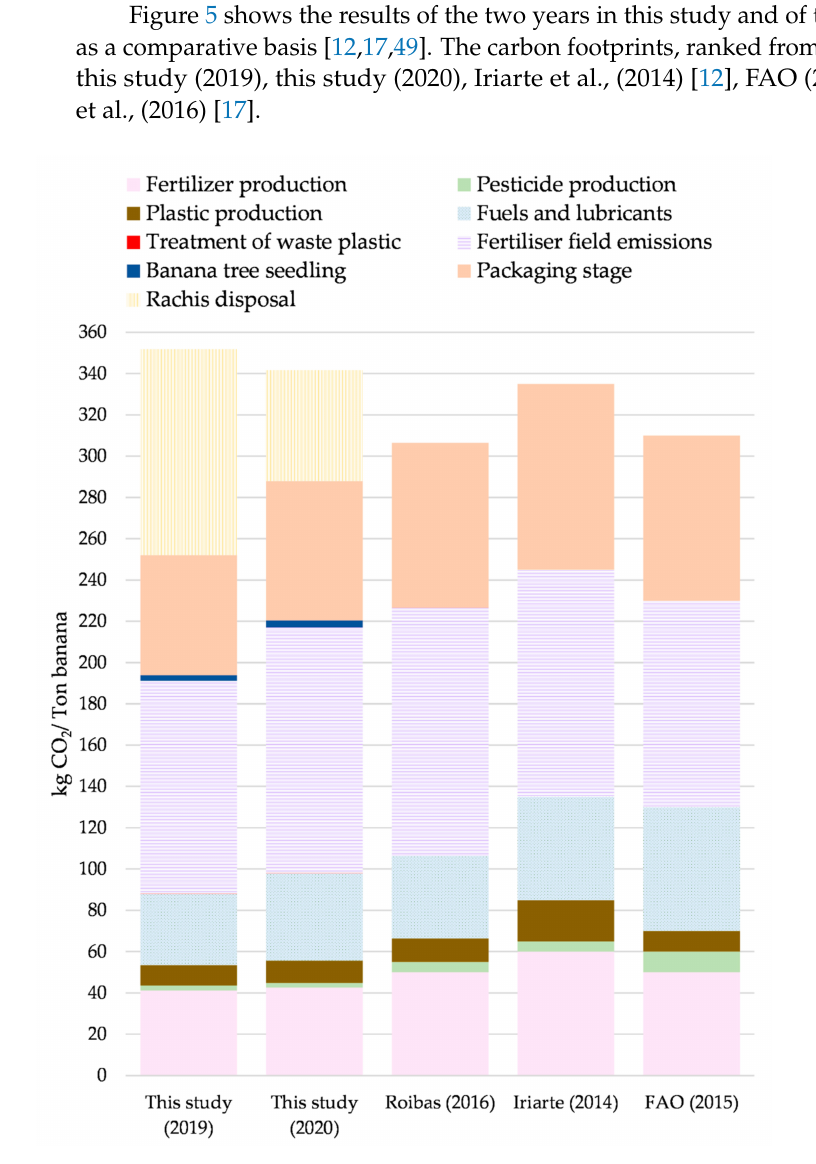
Figure 5. Comparison with carbon footprints of other studies [11,16,48], at “Banana